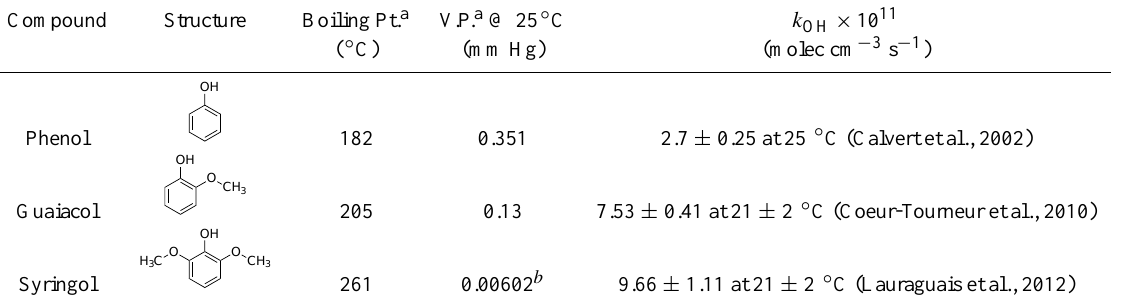
Table 1. Chemical properties.